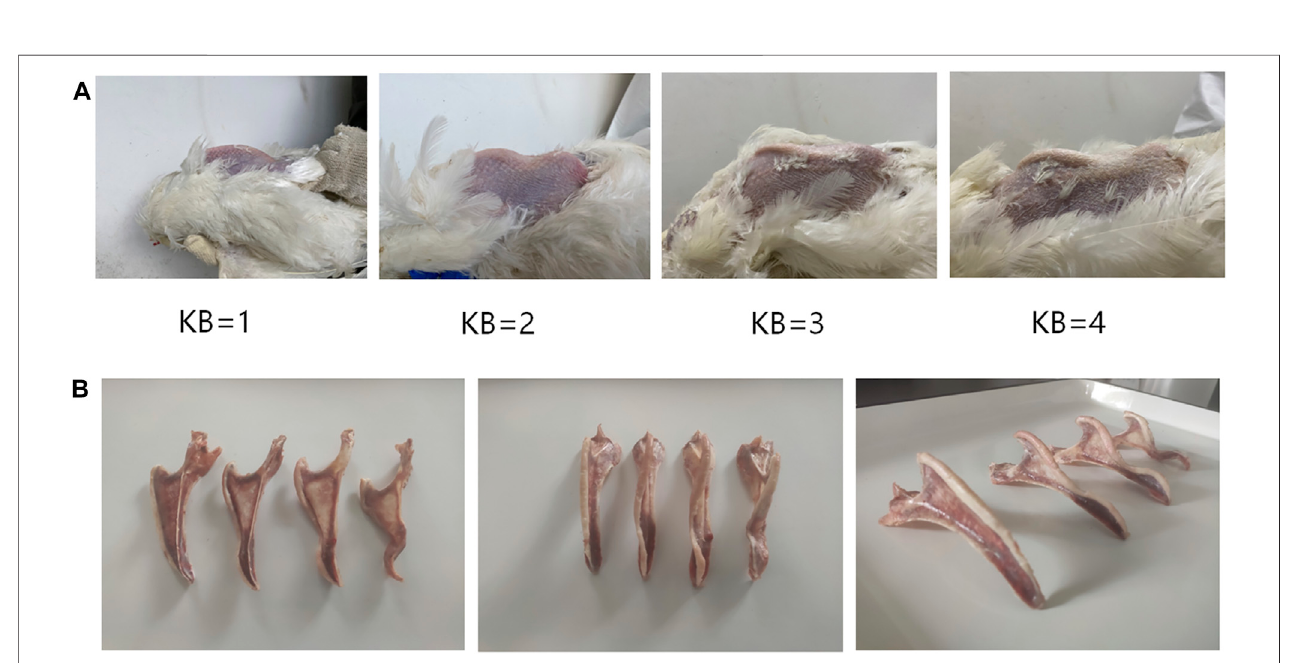
FIGURE 1 | (A) Reference images of KB levels in White Leghorn laying hens (B) Anatomical diagram of KB levels in White Leghorn laying hens.